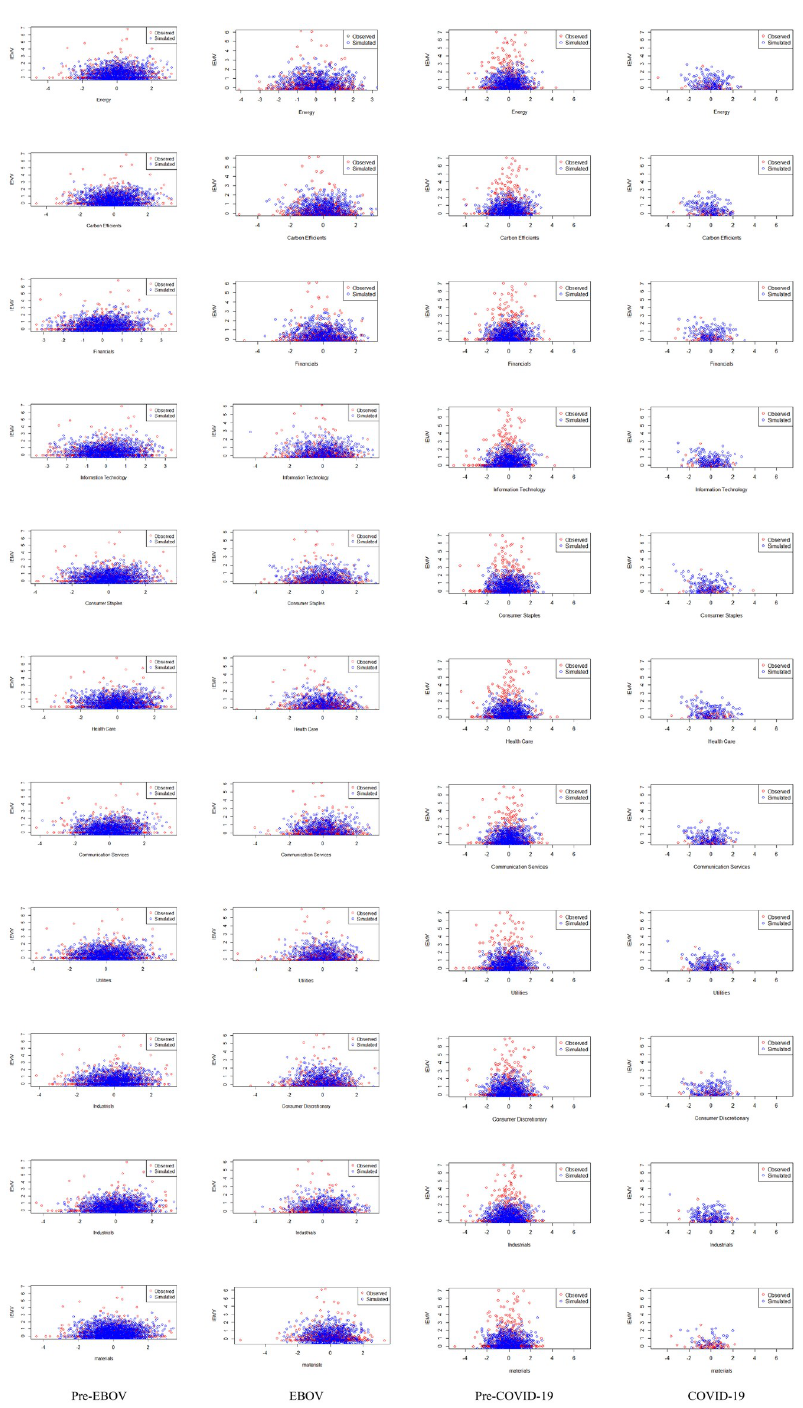
Fig 6. Simulation of each bivariate copula function for every four periods. The red point indicates the observation data, and the blue point shows the simulated data. The results confirm that the generated data through the simulation process from copula functions are very close to observation data except for the pre-COVID-19 period (https:// ndownloader.figshare.com/files/29099883).